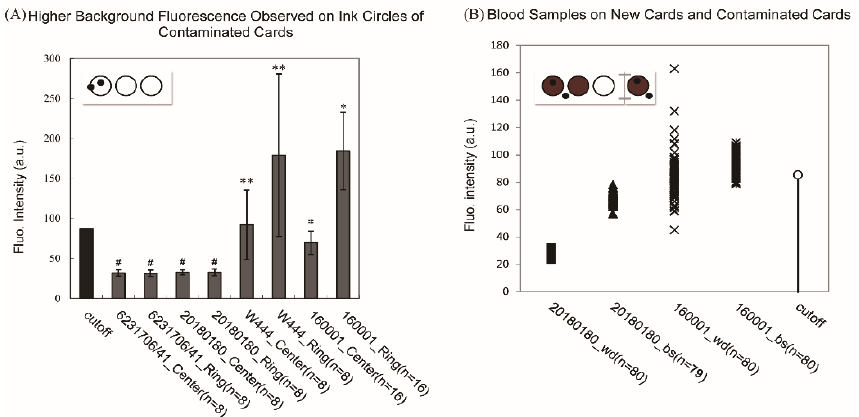
Figure 3. The di ff erence between new collection devices and contaminated collection devices were identified by fluorescent tests. ( A ) White filter paper discs were punched from unused collection devices either on the ink circle or within the circle for background tests; and locations of discs on the collections devices are shown by round black dots either on the ink ring or inside the ring on the inset diagram. Contaminated collection devices showed higher fluorescence background than new collection devices, and fluorescence intensities of paper discs from the ink circle (ring) are significantly higher than that of discs from the center area (center) without ink. Two-tailed unpaired t-tests were conducted for the di ff erential analyses. (#, p > 0.7; **, p = 0.010; *, p < 0.001). Error bars were 99.5% confidential intervals around the mean value of fluorescence intensities. ( B ) Single pieces of new card (Lot20180180, right section of the card with one ink circle) were attached to contaminated collection devices (Lot160001, left part of the card with three ink circles) and used for blood sampling as shown by the inset diagram. Punch locations were shown as round black dots. Blood discs (bs) and white filter discs (wd) from both old (* and × are data lables for bs and wd samples, respectively) and new collection devices ( (cid:78) and (cid:4) are data lables for bs and wd samples) were tested. In the 20180180 bs data set ( n = 79), in one of 80 cases, the attached new card was not used by the individual collecting the blood sample in the